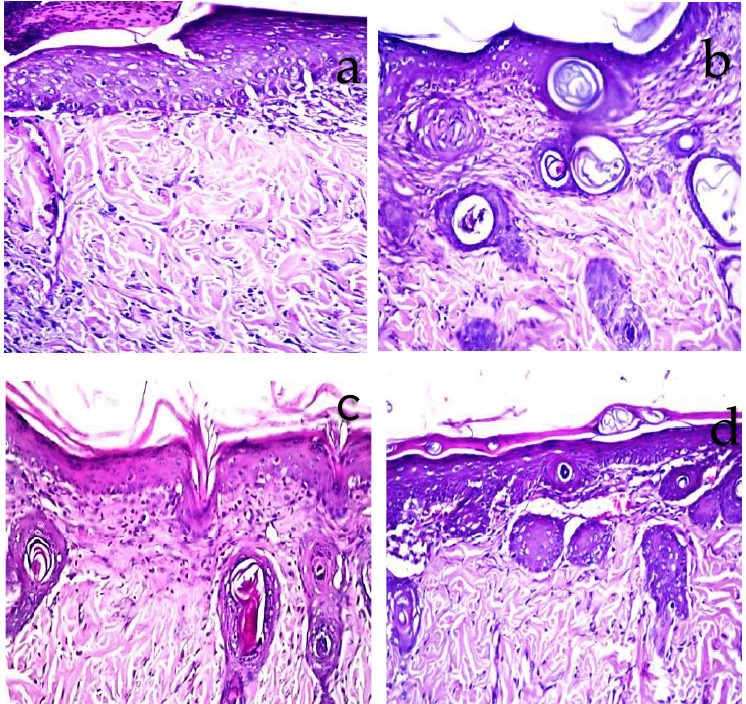
Figure 7. Photomicrographs of treated rat skin compared to the negative control taken at magnifi- cation ×40. ( a ) Skin area treated with normal saline showing oedema with focal ulceration and adja- cent acanthosis in the epidermis with underlying granulation tissue and inflammatory cell infiltra- tion in the dermis. ( b ) Skin area treated with TTO-loaded conventional gel showing few inflamma- tory cells infiltration in the dermis. ( c ) Skin of rat treated with the unmedicated nanolipogel showing acanthosis in the epidermis associated with few inflammatory cells infiltration in the dermis. ( d ) Skin area treated with TTO-loaded nanolipogel showing normal histological structure.